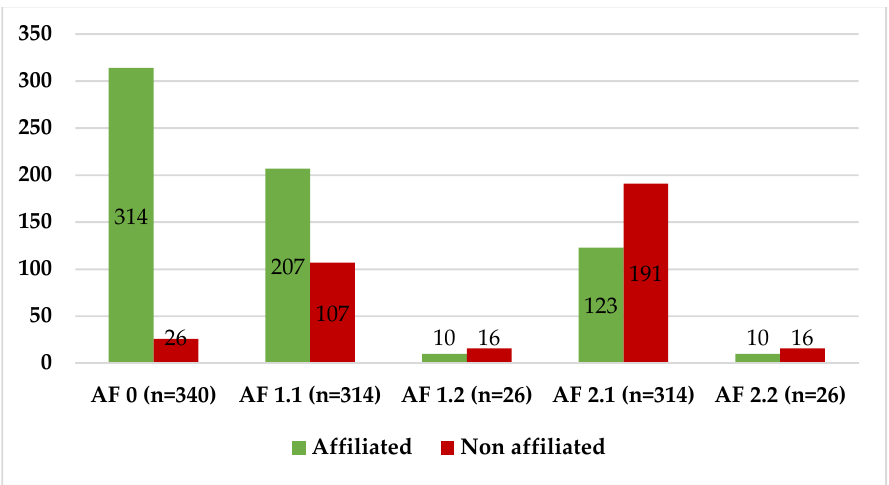
Figure 4. Distribution of the affiliation of informants with Facebook groups, with the Malagasy Embassy in France, and with offline organisation(s) of Malagasy migrants. AF 0: Affiliation with Facebook groups (n = 340); AF 1.1: Facebook-affiliated informants also affiliated with offline Malagasy group(s) (n = 314); AF 1.2: Facebook-affiliated informants who are not affiliated with offline Malagasy group(s) (n = 26)AF 2.1: Facebook-affiliated informants who are affiliated with the Malagasy Embassy (n = 314); AF 2.2: Facebook-affiliated informants who are not affiliated with the Malagasy Embassy (n = 26).